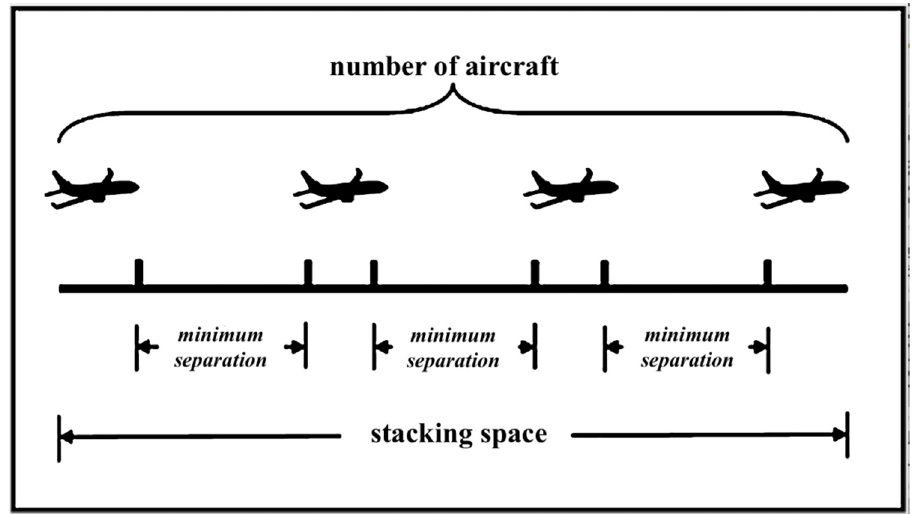
Figure 6. Parameters of our model for aircrafts approaching airports with CDA.